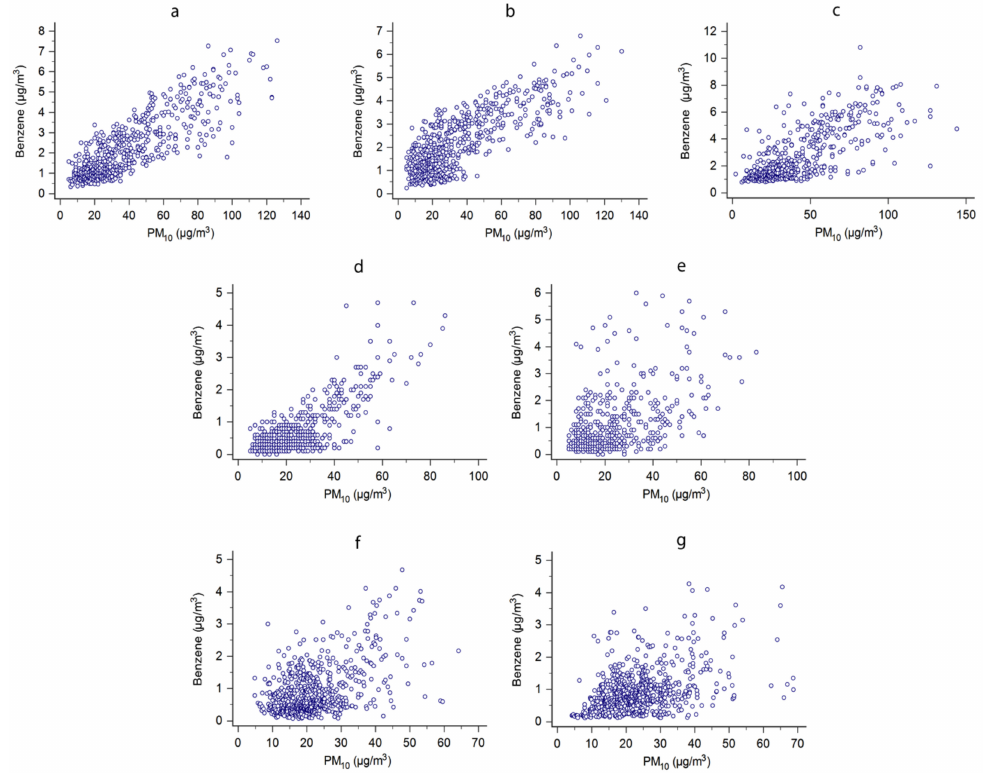
Figure 2. Linear regression between benzene and PM 10 concentrations in the stations of ( a ) Consolata ( r = 0.8473); ( b ) Rubino ( r = 0.7986); ( c ) Rebaudengo ( r = 0.7486); ( d ) Cortonese ( r = 0.7839); ( e ) Fontivegge ( r = 0.5260); ( f ) Garigliano ( r = 0.5001); ( g ) Libertini ( r = 0.4179). Table 4. Non-carcinogenic risk (HQ) associated with exposure to benzene in Torino, Perugia, and Lecce. HQ Cities Station